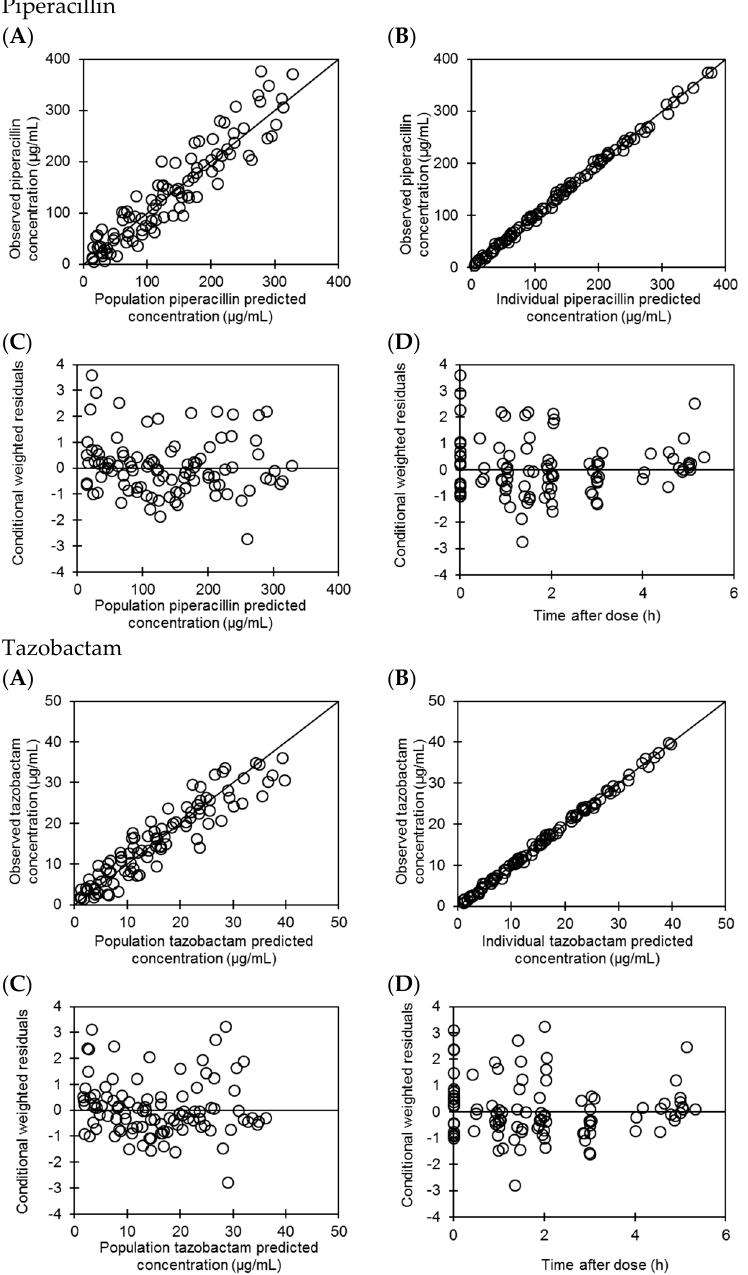
Figure 2. Goodness-of-fit plot of the final model. ( A ) Observed vs. population predicted concentration, ( B ) Observed vs. individual predicted concentration, ( C ) Conditional weighted residuals vs. population predicted concentration, ( D ) Conditional weighted residuals vs. time after dose.